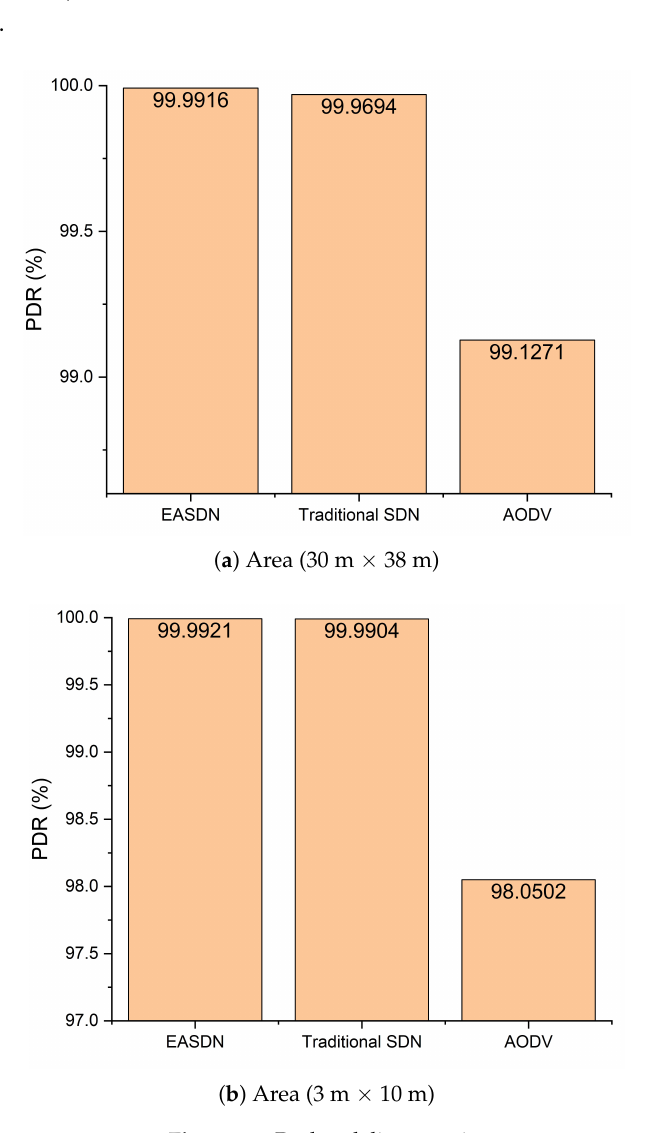
Figure 12. Packet delivery